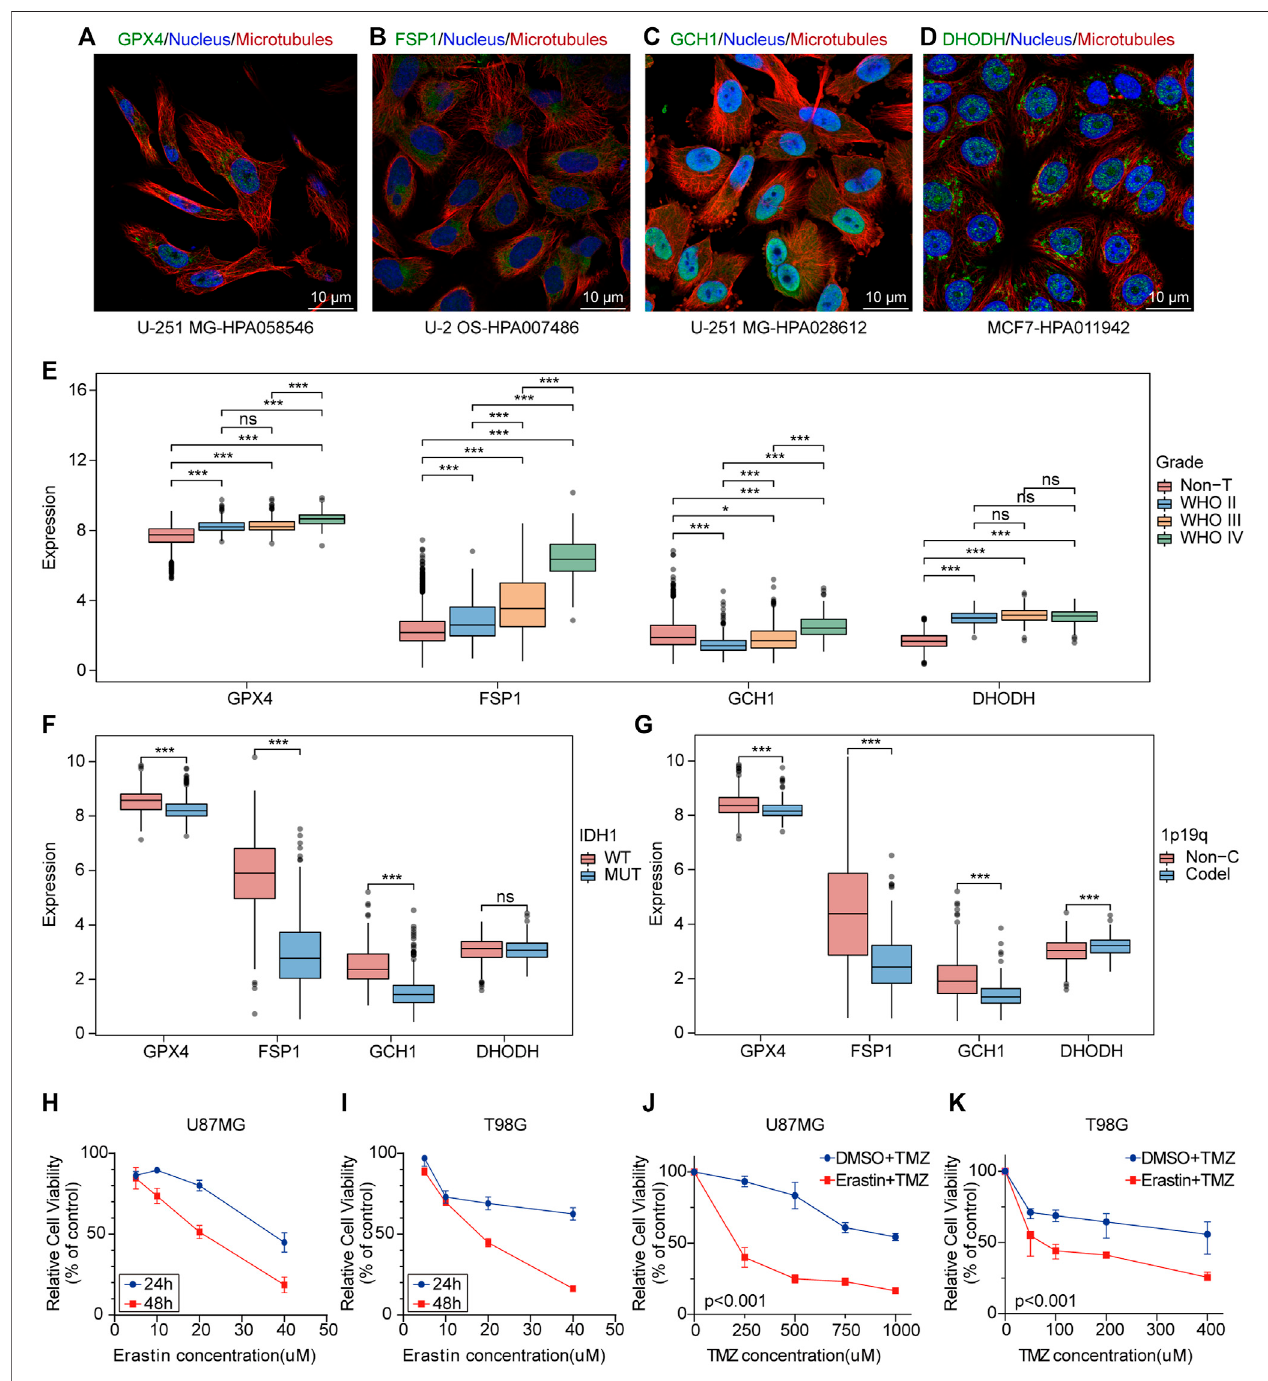
FIGURE 1 | Ferroptosis plays an potential biological role in the progression and treatment of glioma. (A – D) Confocal immuno fl uorescence staining for GPX4 , DHODH , GCH1 , FSP1 in cell lines from HPA database. Green, antibody; blue, nucleus; red, microtubules. (E – G ) Boxplots of GPX4 , GCH1 , FSP 1 and DHODH expression in different grade, IDH1-status and 1p19q-codeletion-status glioma samples from TCGA database. ns, no signi fi cance; * p < 0.05; ** p < 0.01; *** p < 0.001. (H,I) ThecellviabilityofU87MGand T98G cellstransfected witherastinwasevaluatedbytheCCK-8assaysin24and48 h. Fivetechnicalrepeatswereperformed for two biological repeats. (G,K) The cell viability of U87MG and T98G cells transfected with erastin and temozolomide was evaluated by the CCK8 assays in 48 h. Five technical repeats were performed for two biological repeats.